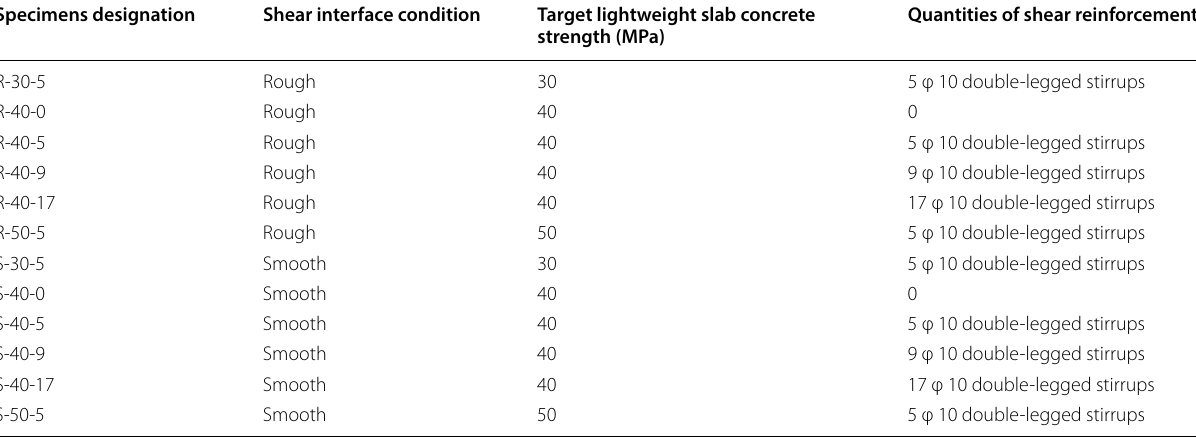
Table 1 Specimens designation and test